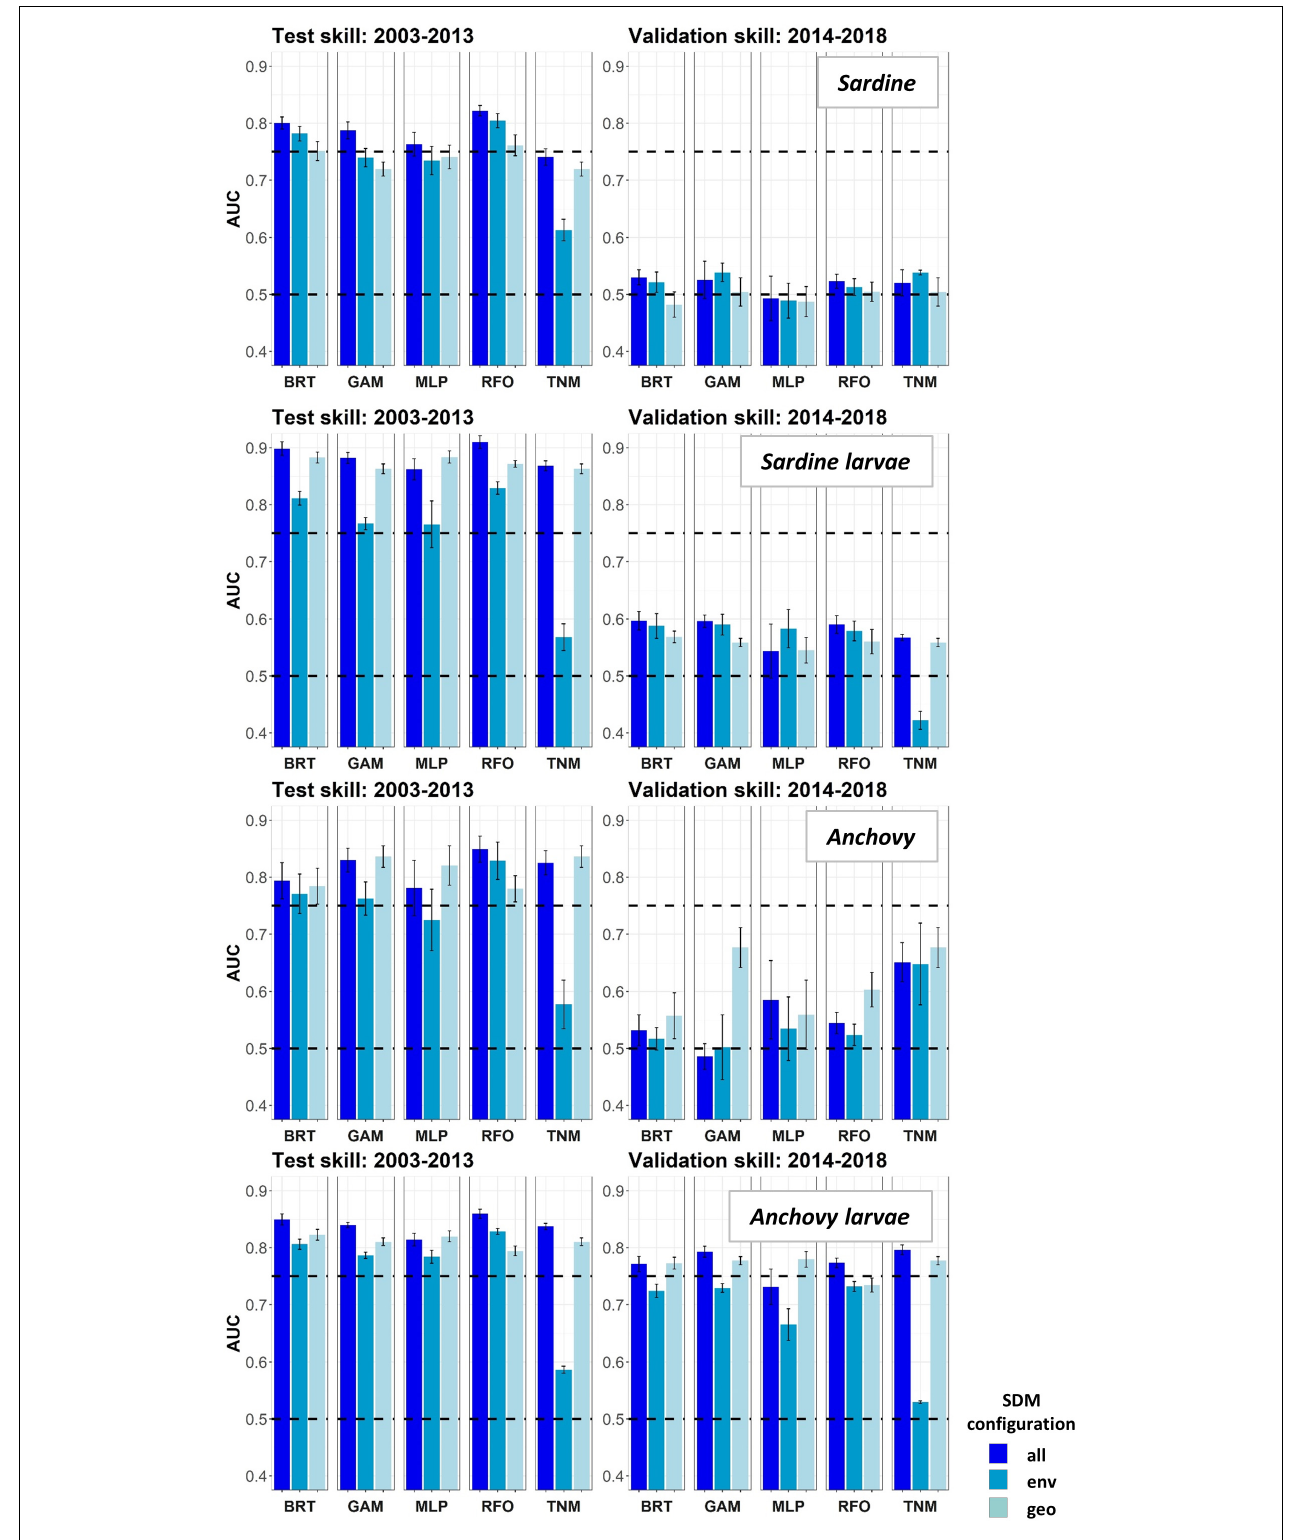
FIGURE 3 | Area Under the Receiver Operating Curve (AUC) skill metrics for Experiment 1 SDMs. Means and standard deviations across all SDM ensembles (see Figure 1 ) are shown for each life stage of each species. Colors of bars denote the SDM configuration (“all,” “env,” or “geo”). The horizontal black dashed lines show AUC values of 0.5 (no better than a random model), and 0.75 (a rough approximation of a “useful” model), for reference.